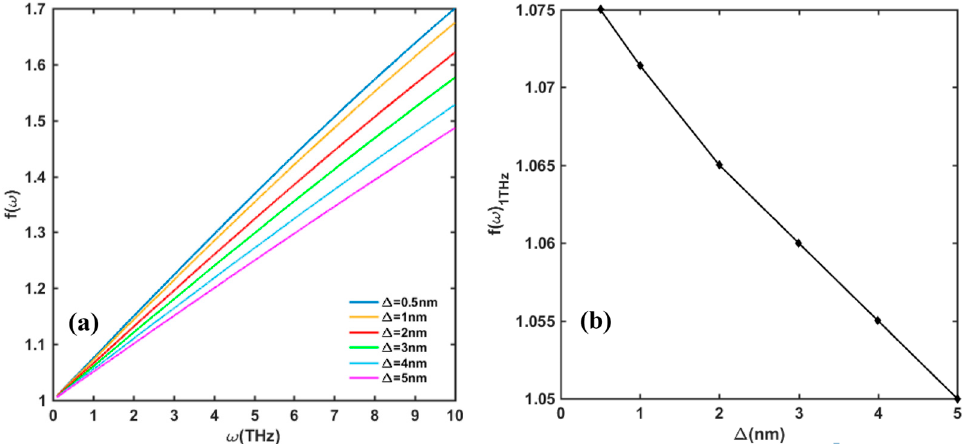
Figure 8. ( a ) Change in f( ω ) with interface roughness Δ in frequency range of 0.1–10 THz. ( b ) Value of f( ω ) at 1 THz incident frequency with change in Δ . Other parameters are taken as n s = 10 13 /cm 2 , N dis = 10 10 /cm 2 , and Λ = 10 nm.